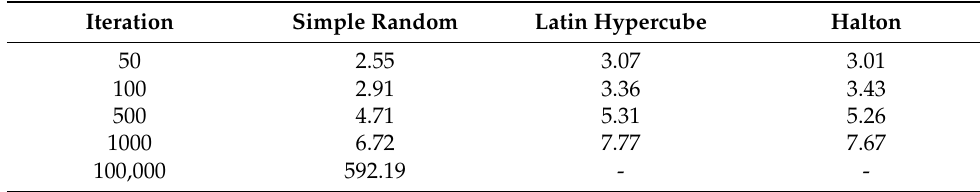
Table 5. Calculation time for different simulation